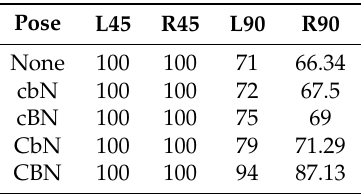
Table 2. Accuracy of the combination of components. ’C’ and ’c’ represents face cropping and without cropping, ’B’ and ’b’ represents face rendering with a background without the background, ’N’ represents rendering 512 faces each scan, L45 and R45 represent facial images with − 45 and 45 degrees on the horizontal plane, L90 and R90 represent facial images with − 90 and 90 degrees on the horizontal